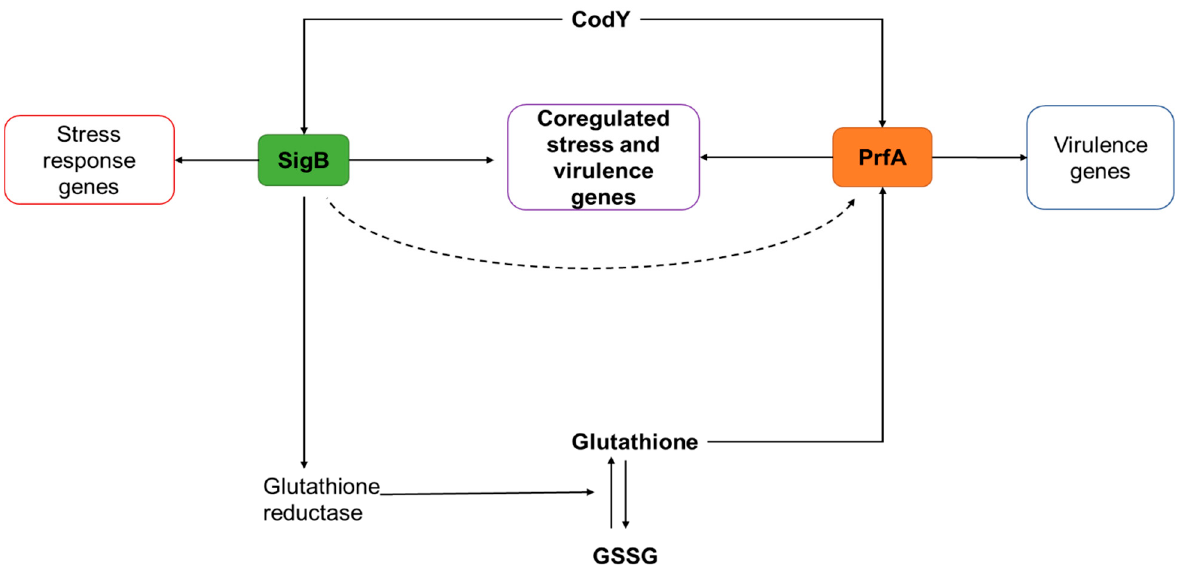
Figure 5. An illustration of the overlap and interactions between SigB and PrfA in L. monocytogenes . Solid arrows indicate positive regulation. The dotted arrow indicates negative regulation.